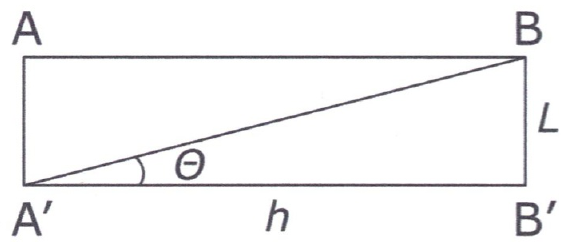
Fig. 7. Graphical illustration of relationship between θ , effective length ( L) , and lag distance( h)